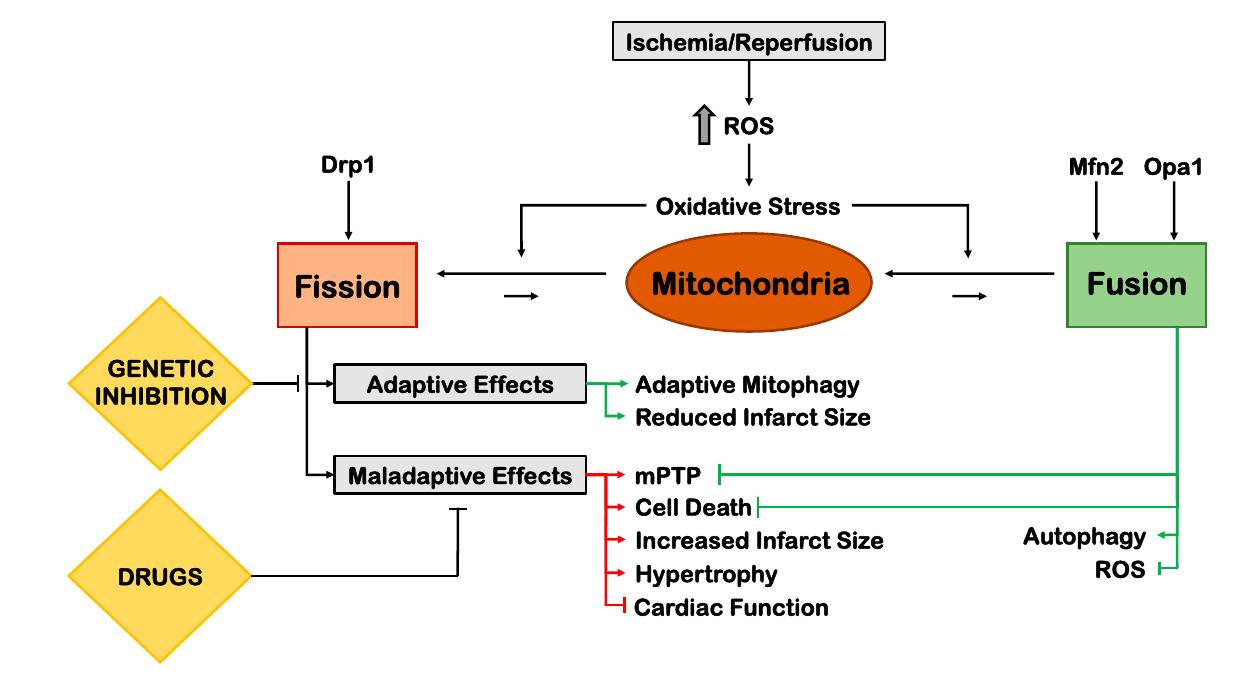
Figure 6. The role of mitochondrial dynamics in myocardial ischemia. Pharmacological inhibition of fission or fusion activation reduces cardiac injury. DRP1, dynamin-related protein 1; Mfn2, mi- tofusin 2; mPTP, mitochondrial permeability transition pore; Opa1, optic atrophy gene 1; ROS, re- active oxygen species.